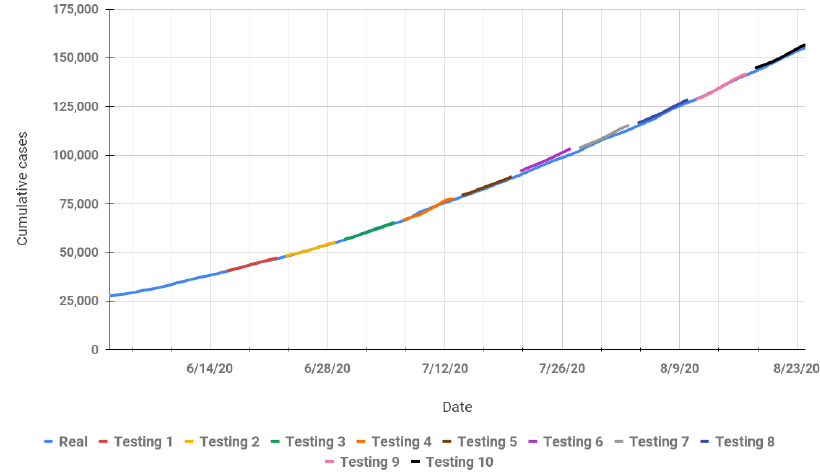
Figure 9. Actual and short-term forecasting for cumulative COVID-19 cases using the FPA model.